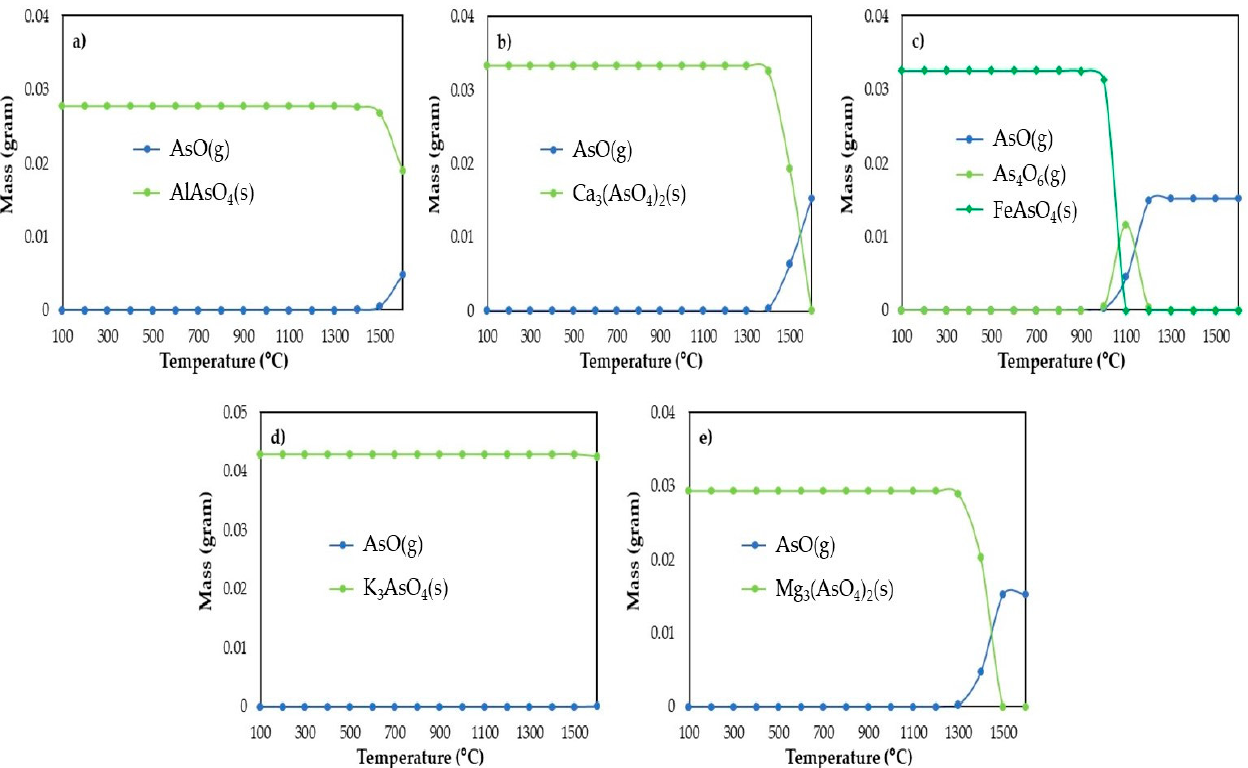
Minerals 2021 , 11 , x Figure 1. Equilibrium composition of As-Mineral oxides interactions during combustion: ( a ) As-O 2 -Al 2 O 3 ; ( b ) As-O 2 -CaO; ( c ) As-O 2 -Fe 2 O 3 ; ( d ) As-O 2 -K 2 O; ( e ) As-O 2 -MgO.